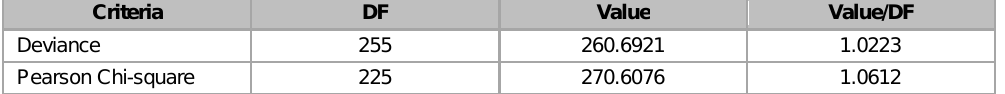
Goodness of fit statistic for the quasi logistic regression